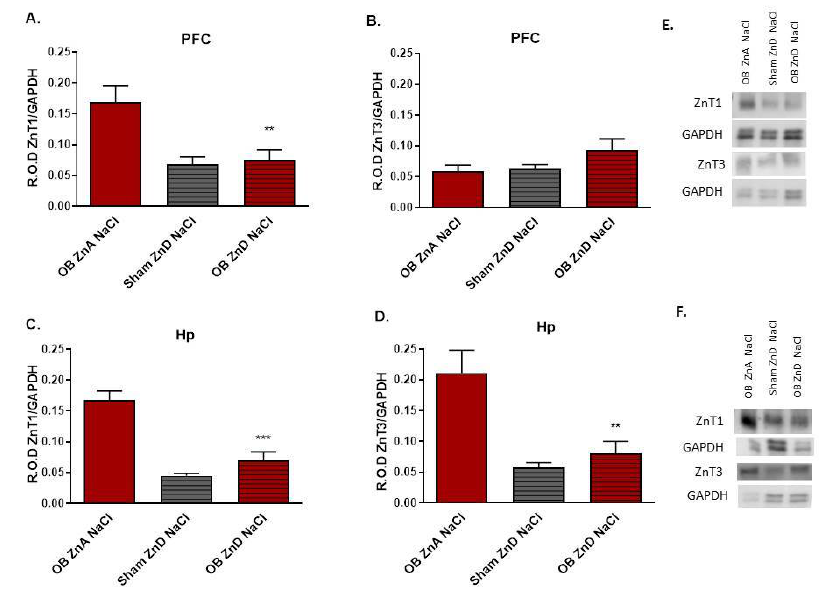
Figure 5. The effects of OB, ZnD, and OB + ZnD models on the zinc transporter protein levels in the prefrontal cortex (PFC, ( A , B )) and hippocampus (Hp, ( C , D )). Representative blots for PFC ( E ); representative blots for Hp ( F ). Data were analyzed using a one-way ANOVA and the Newman–Keuls multiple comparisons test. Values are expressed as mean ± SEM ( n = 6–7). OB: olfactory bulbectomy model, ZnD: zinc-deficient diet, OB + ZnD: olfactory bulbectomy model and zinc-deficient diet GAPDH: glyceraldehyde-3-phosphate dehydrogenase, R.O.D ZnT1: relative optical density of zinc transporter 1, R.O.D ZnT3: relative optical density of zinc transporter 3. ** p < 0.01; *** p <